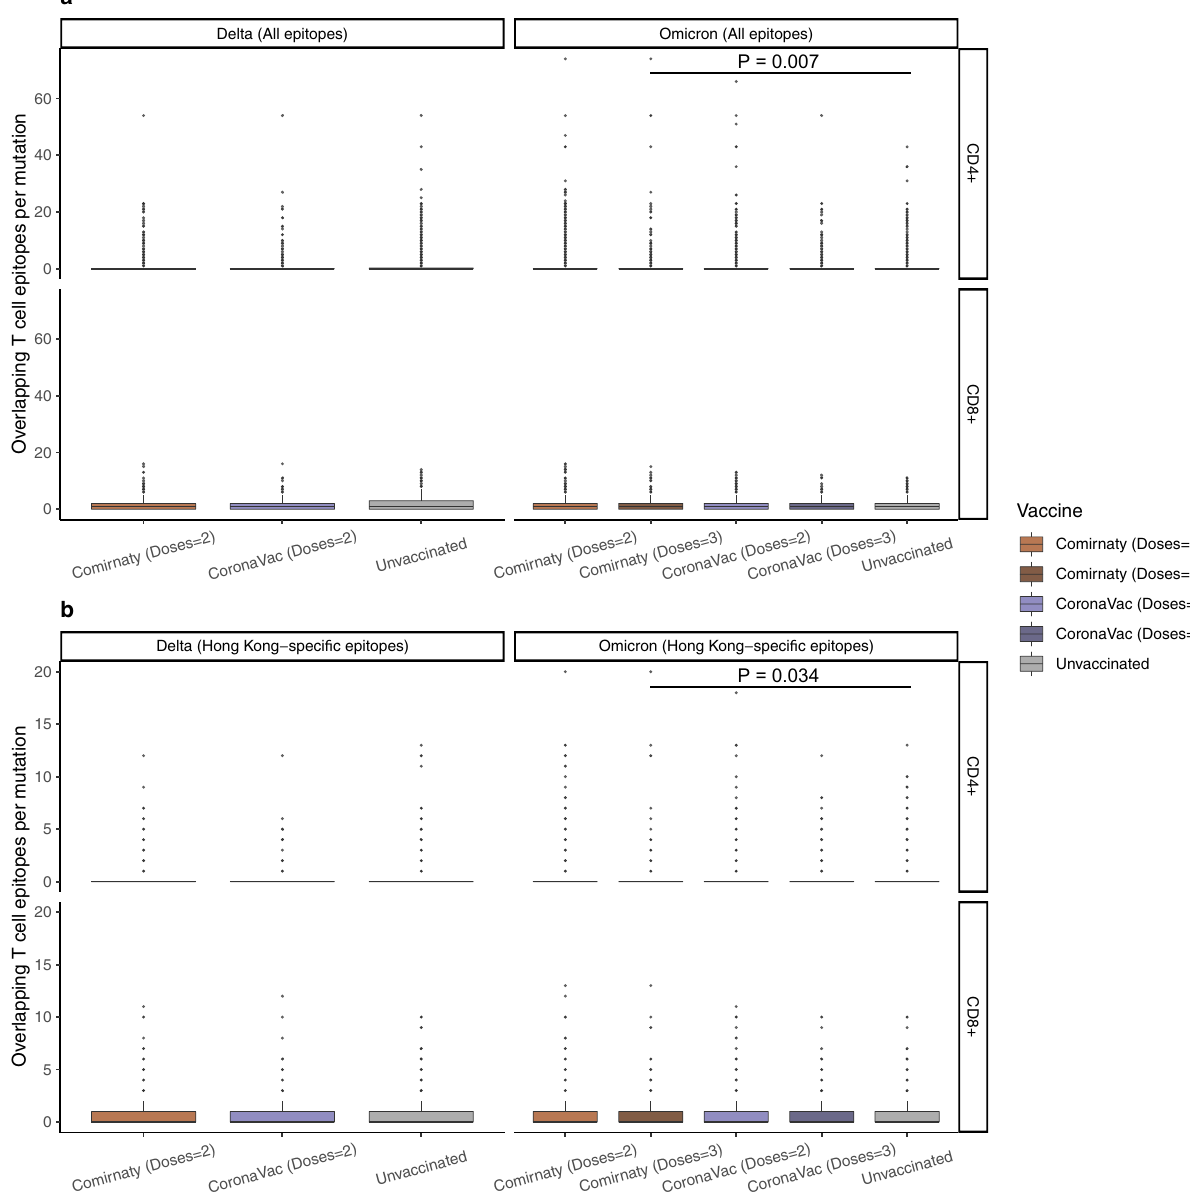
Wilcoxon test. For all box plots, the bold horizontal line inside the box shows the median, the upper and lower edges of the box indicate the fi rst and the third quartiles,andwhiskersextendtospana1.5interquartilerangefromtheedges.The sample size of datain eachgroup areshown in SupplementaryFig. 6and 9.Source data are provided as a Source Data fi